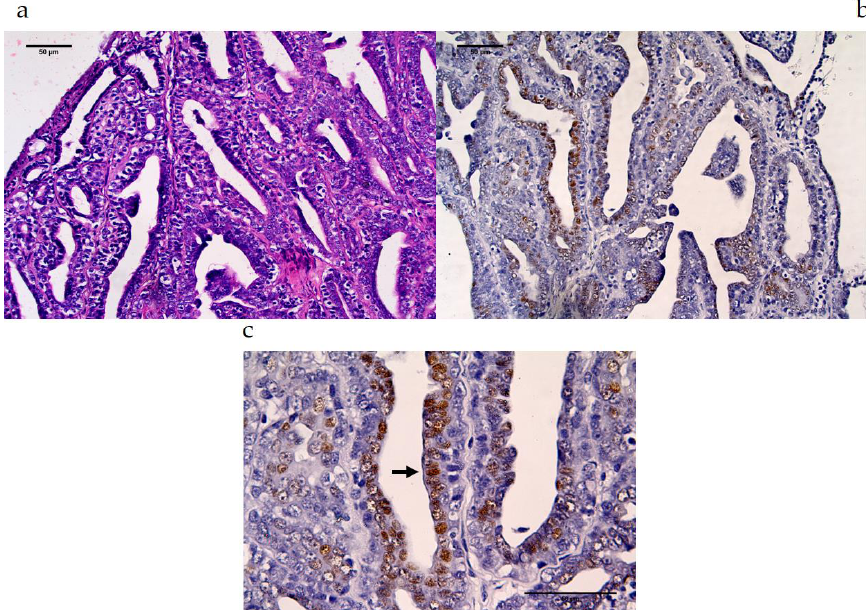
Figure 4 . Positive cross - reactivity of MAb 6C1, mammary gland tumors and canines . Location of Figure 4. Positive cross-reactivity of MAb 6C1, mammary gland tumors and canines. Location of MAGE expression in the simple tubular carcinoma type of malignant mammary gland tumor section Ma2: ( a ) HE stained, 40 × ; ( b ) IHC-stained-positive, 40 × , ( c ) IHC-stained-positive, 100 × , black arrows are representative of nuclear expression